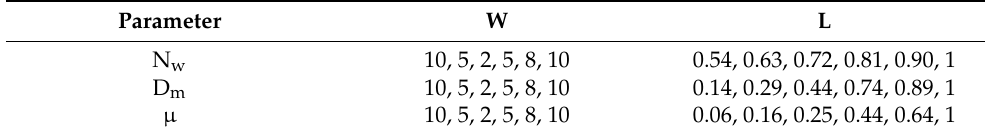
Table 2. The weight coefficient vectors of SLF in different value regions.